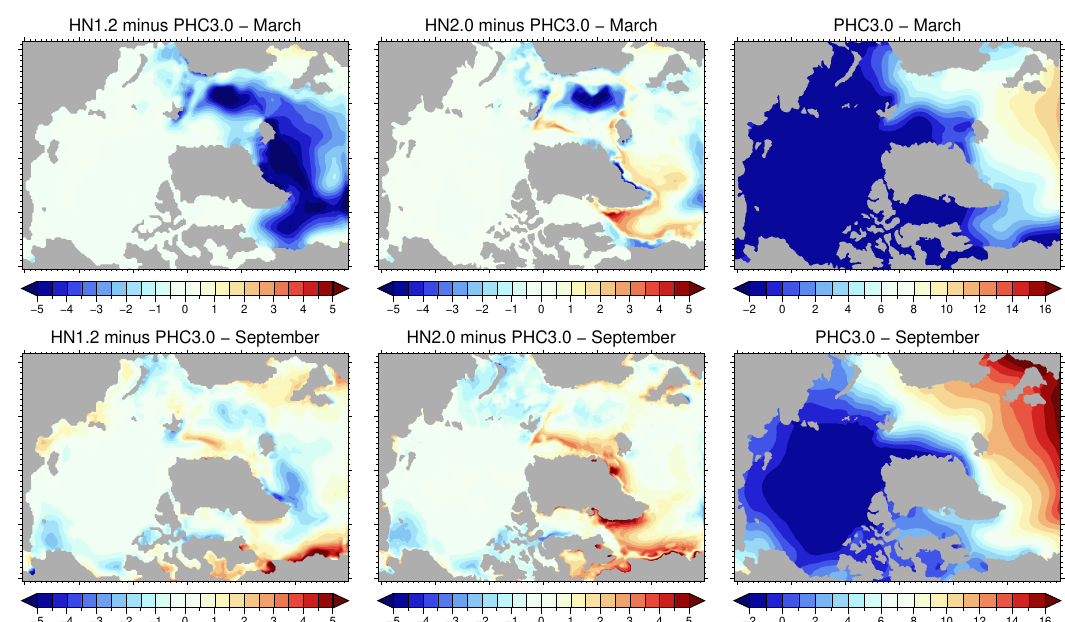
Figure 7. Climatological difference in upper ocean temperature (in degrees Celsius) for March ( top ) and September ( bottom ) from ERAI-driven ensemble simulations with HN1.2 ( left ) and ERAI-driven ensemble simulations with HN2.0 ( middle ). The difference relates to PHC3.0 data ( right ). Upper ocean refers here to the average over the upper 20m of the respective ocean data set. PHC3.0 data were interpolated to the T-grid of HN2.0 (and to the T-grid of HN1.2, respectively, for calculating the difference to HN1.2). Land areas of the T-grid are shown in gray. Note that the T-grids of HN1.2 and HN2.0 slightly differ due to the different horizontal resolution. The model data refer to the